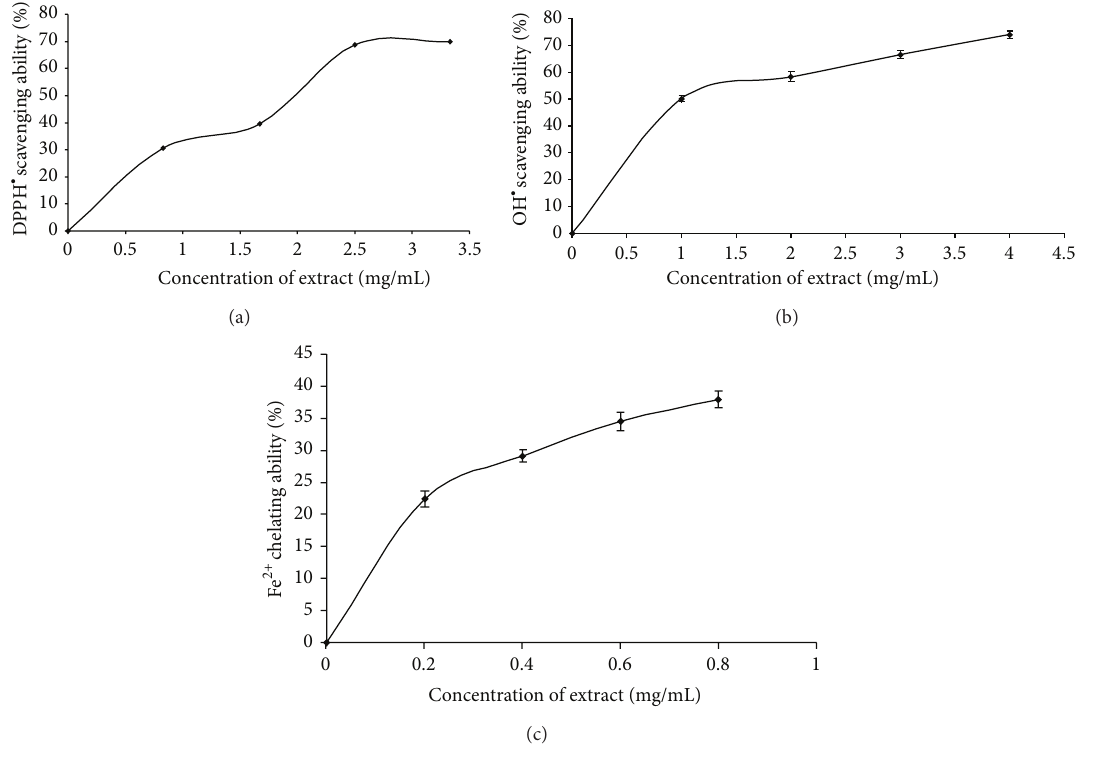
Figure 4: Some antioxidant parameters: (a) DPPH free radical scavenging, (b) OH radical scavenging, and (c) Fe 2+ chelating abilities of aqueous extract of Cola acuminata . Values represent means ± standard deviation of triplicate